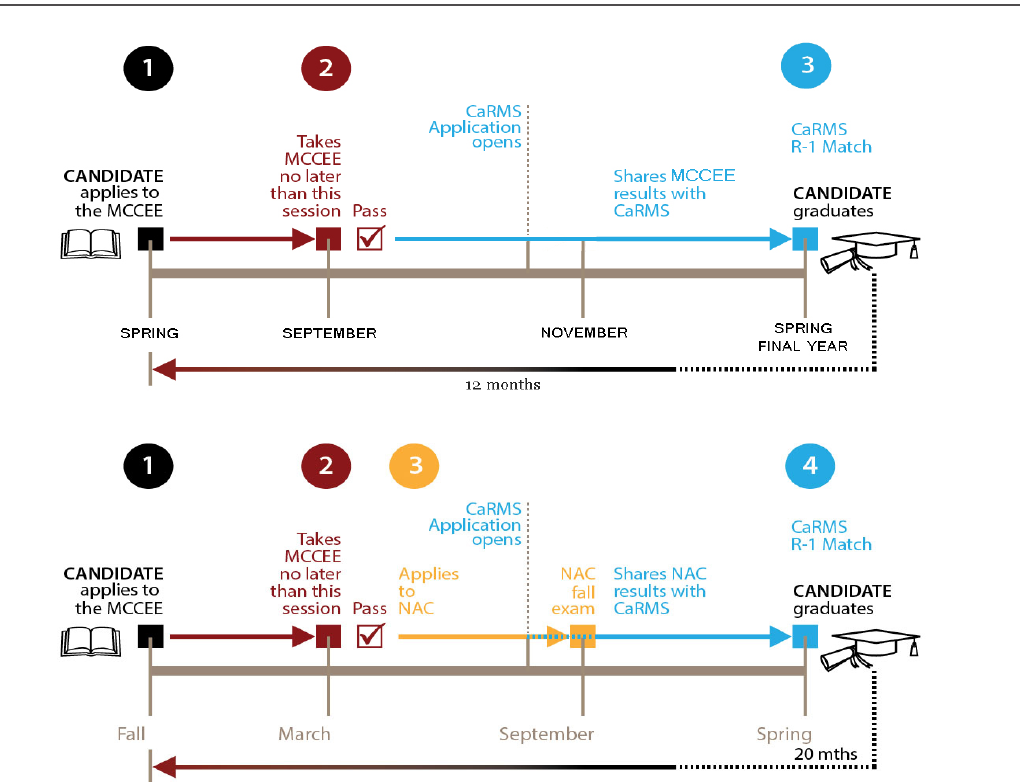
Figure 1. Previous (top) and Current (bottom) Canadian Residency Match System R1 Match